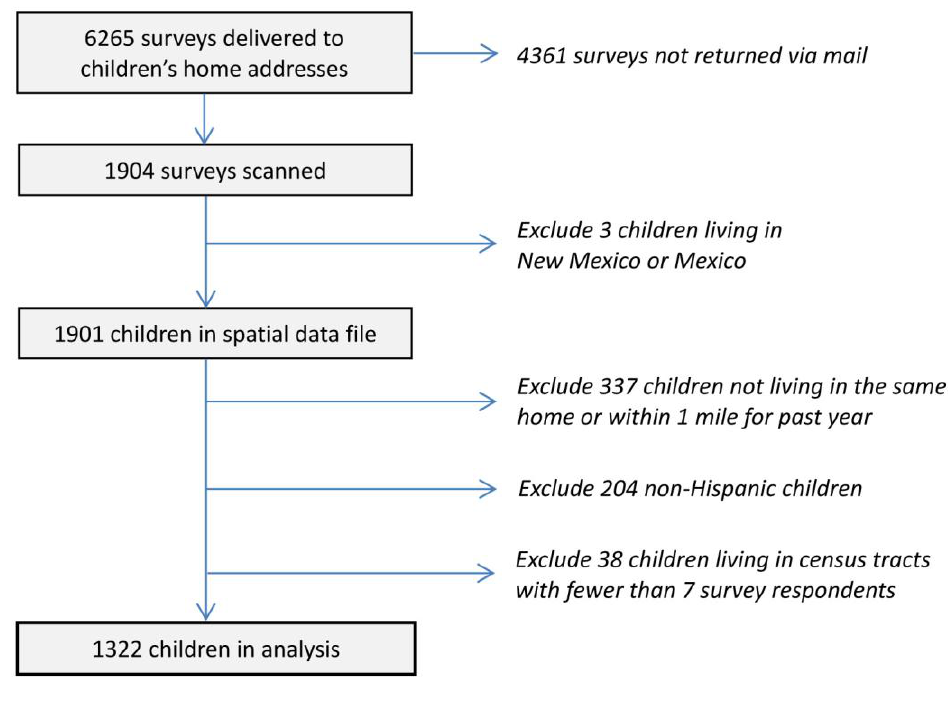
Figure 2. The EPISD survey sample.